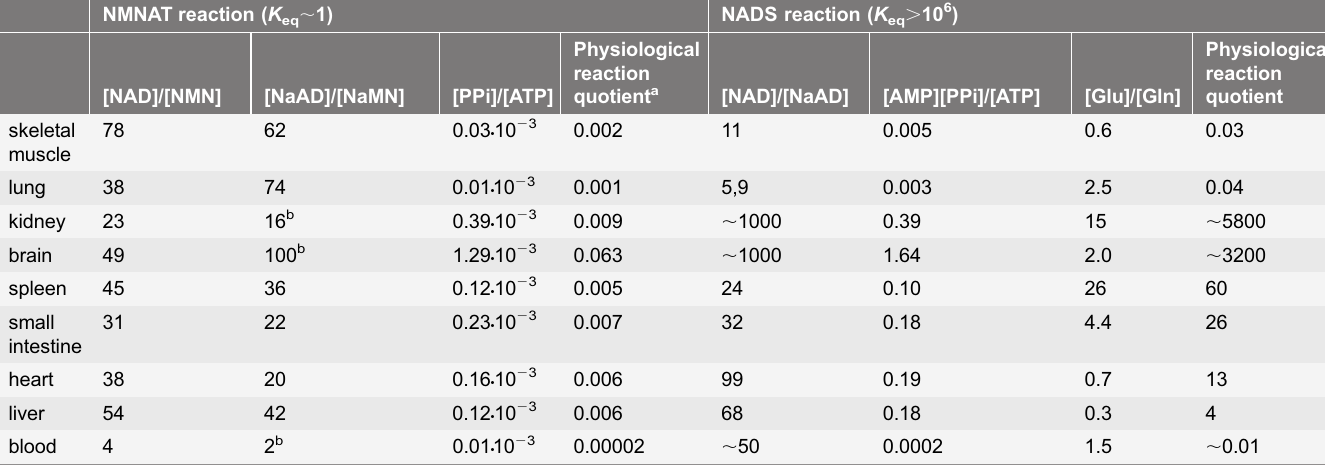
Table 1. Product/substrate ratios and physiological reaction quotients in mouse